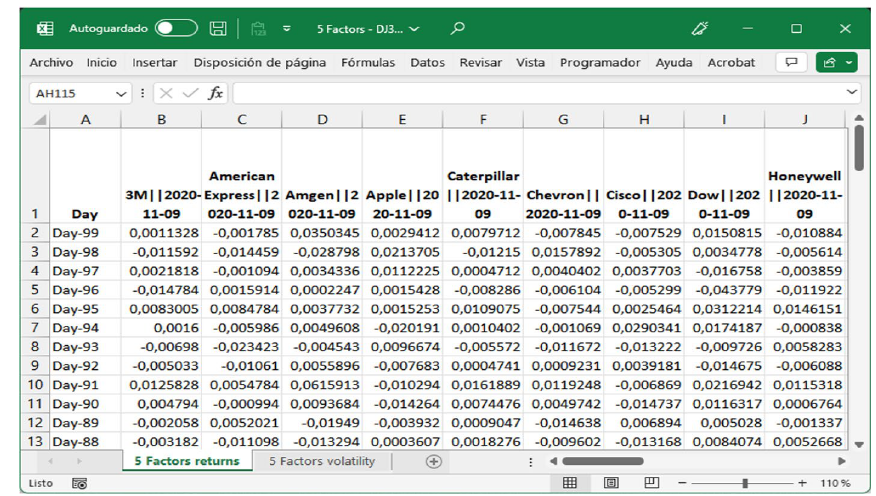
Fig. 19 Five‑factor Excel file downloaded, first columns. Source : Created by authors